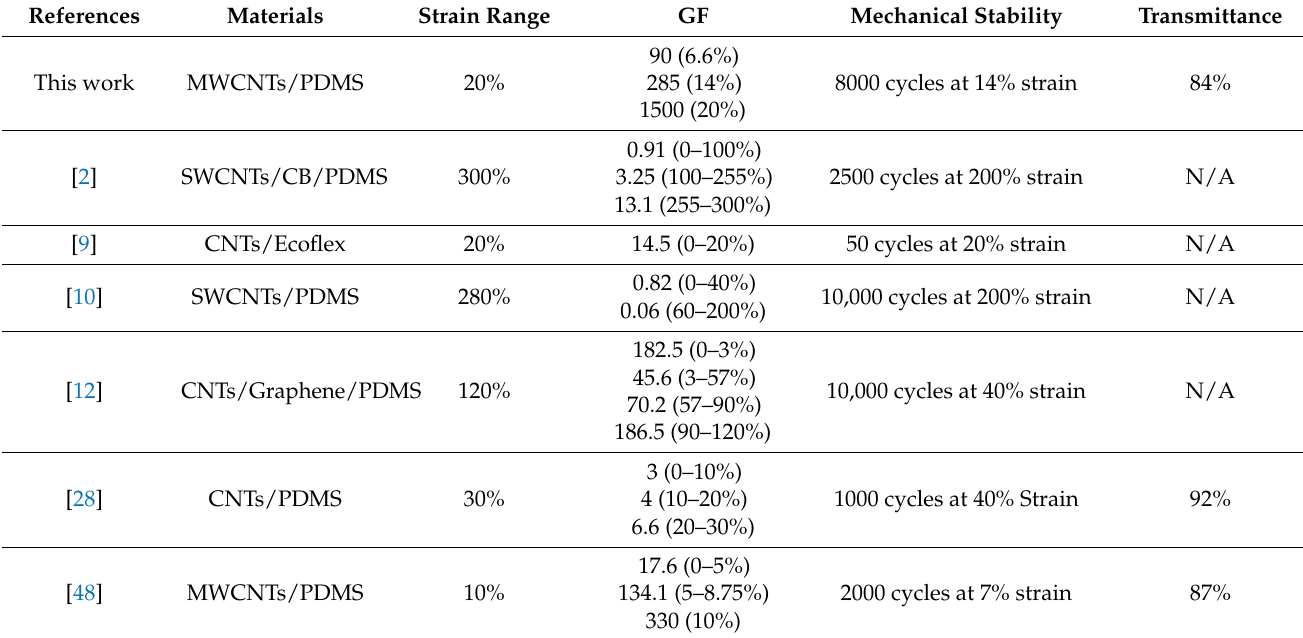
Figure 4. Sensor performance at PDMS ratio of 15:1. ( a ) Normalized resistance of the strain sensor at 6.6%, 14%, and 20% strain. The inset shows the SEM of crack extension after stretching MWCNT ( b ) Response/recovery time of the sensor at a strain of 14%. Table 1. Summary of performance results of carbon-based strain sensors recently